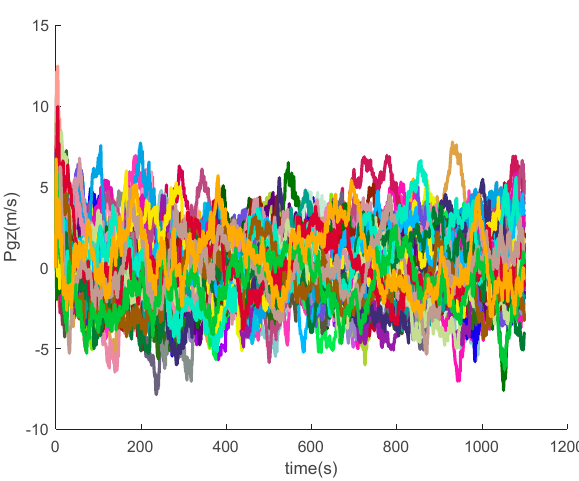
Figure 23. The y -axis position errors of SINS/GPS in the LCEF frame.